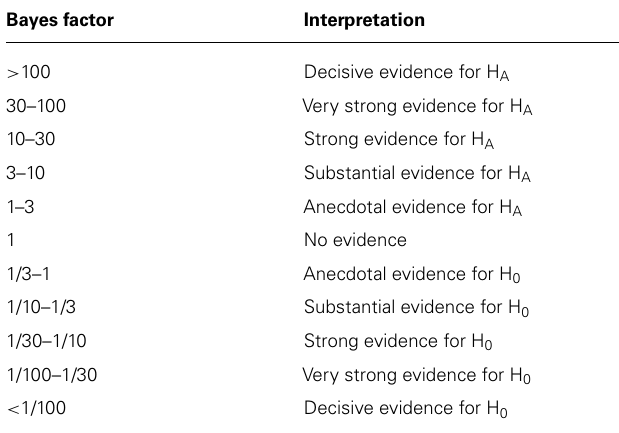
FIGURE 3 |Average BIAS of responses per condition as measured in Experiment 1. Asterisk indicates statistical significance at the 0.05 level. √ prior with scale parameter 2 for the standardized effect size in combination with a Jeffreys prior on the variance. The analysis was performed using the BayesFactor package (Morey et al., 2014) for R (R Development Core Team, 2009). An overview of a common textualinterpretationof BayesFactorvaluesispresentedin Table3